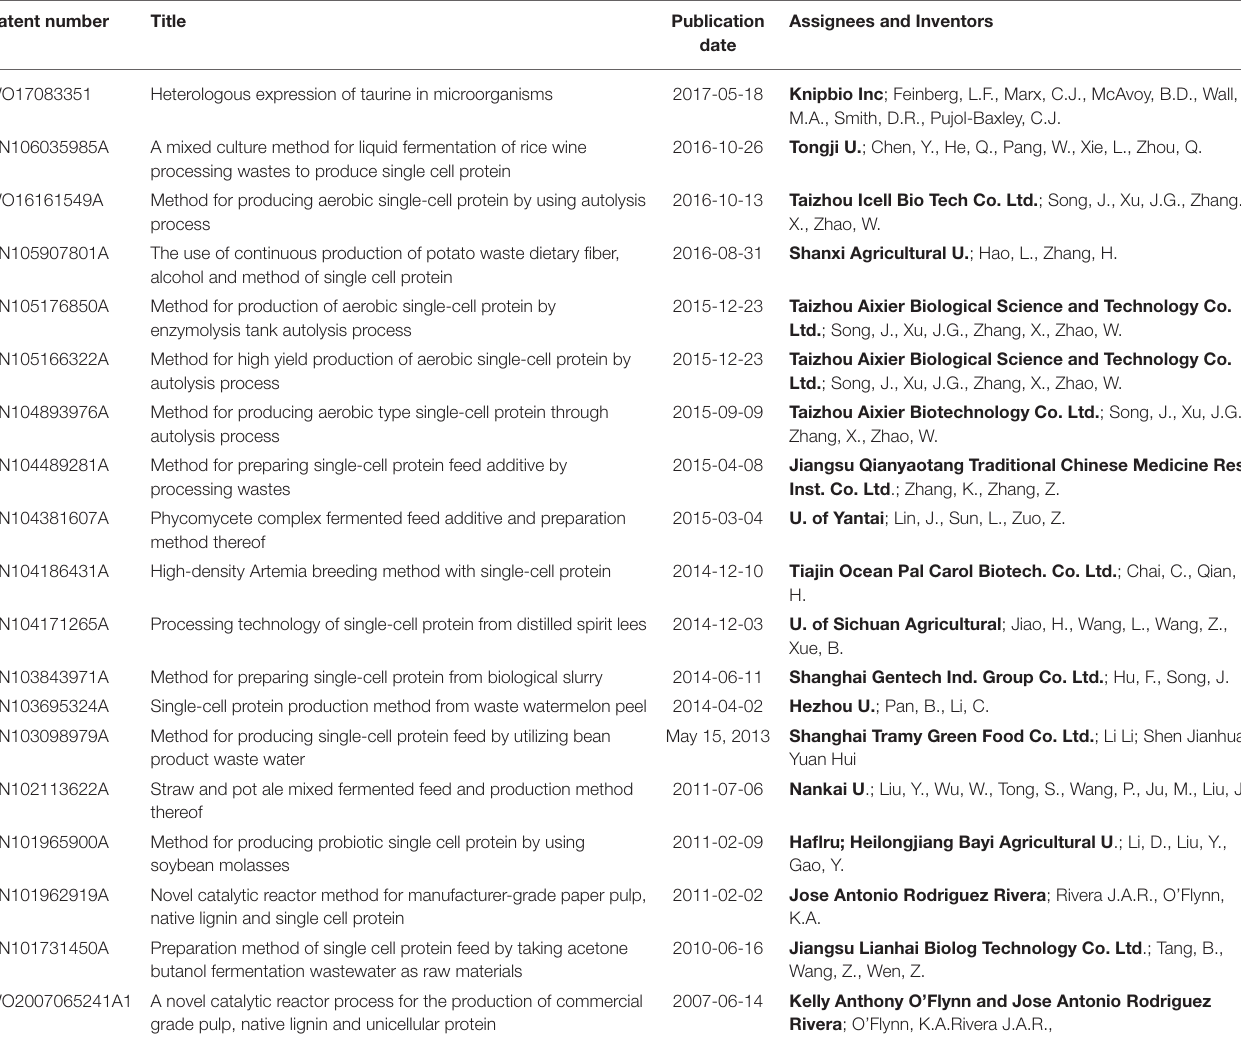
TABLE 8 | Patents related to the production of SCP from mixed microbial populations (bacteria and/or yeast and/or algae) or in which the microorganism was not specified during